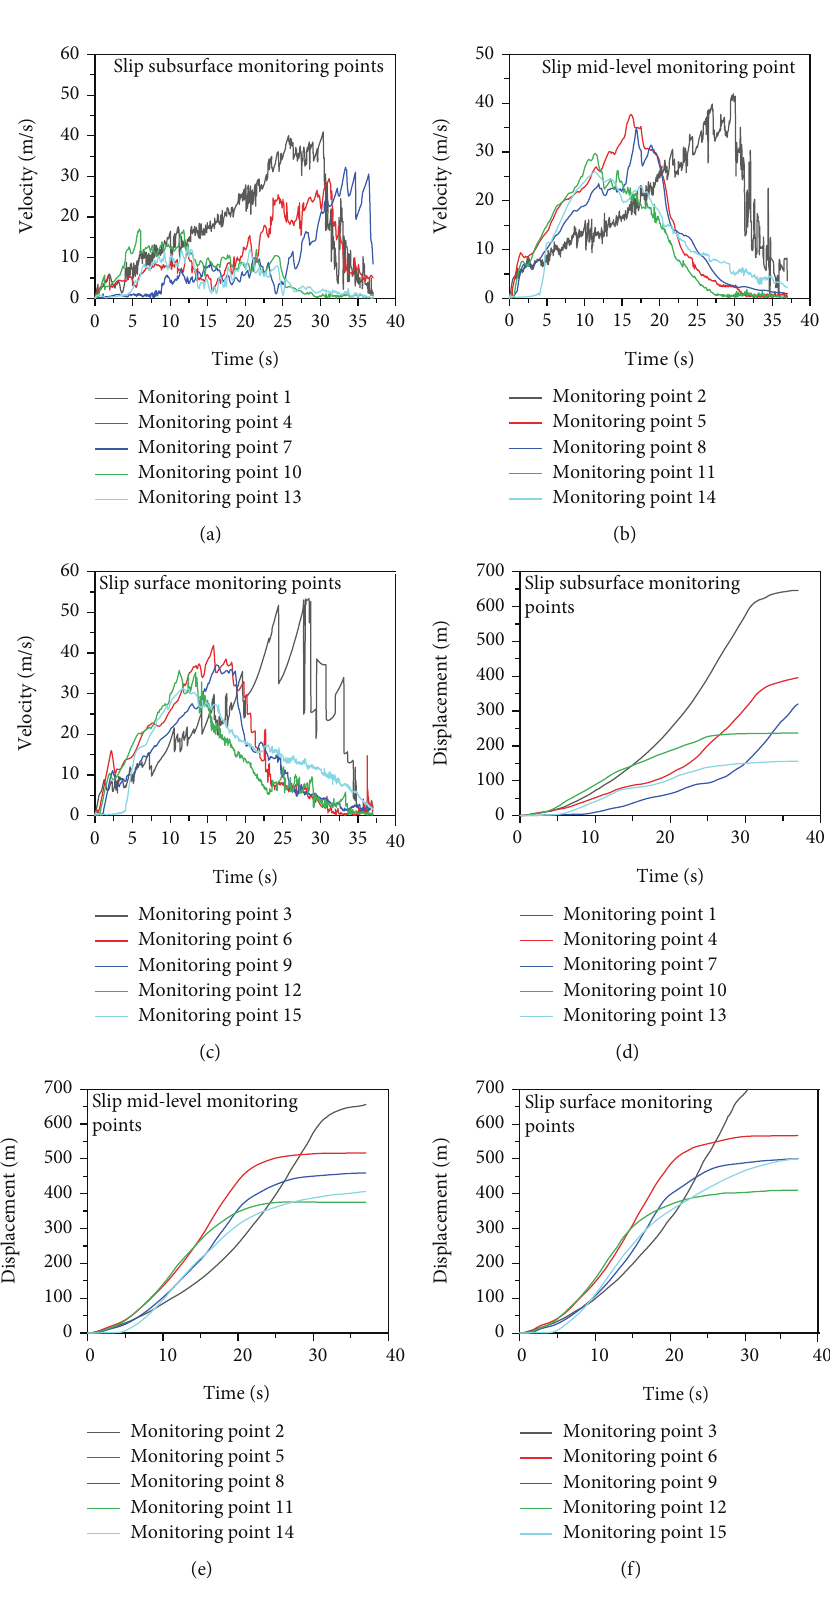
Figure 14: Comparison of velocity displacements at surface, middle, and lower monitoring